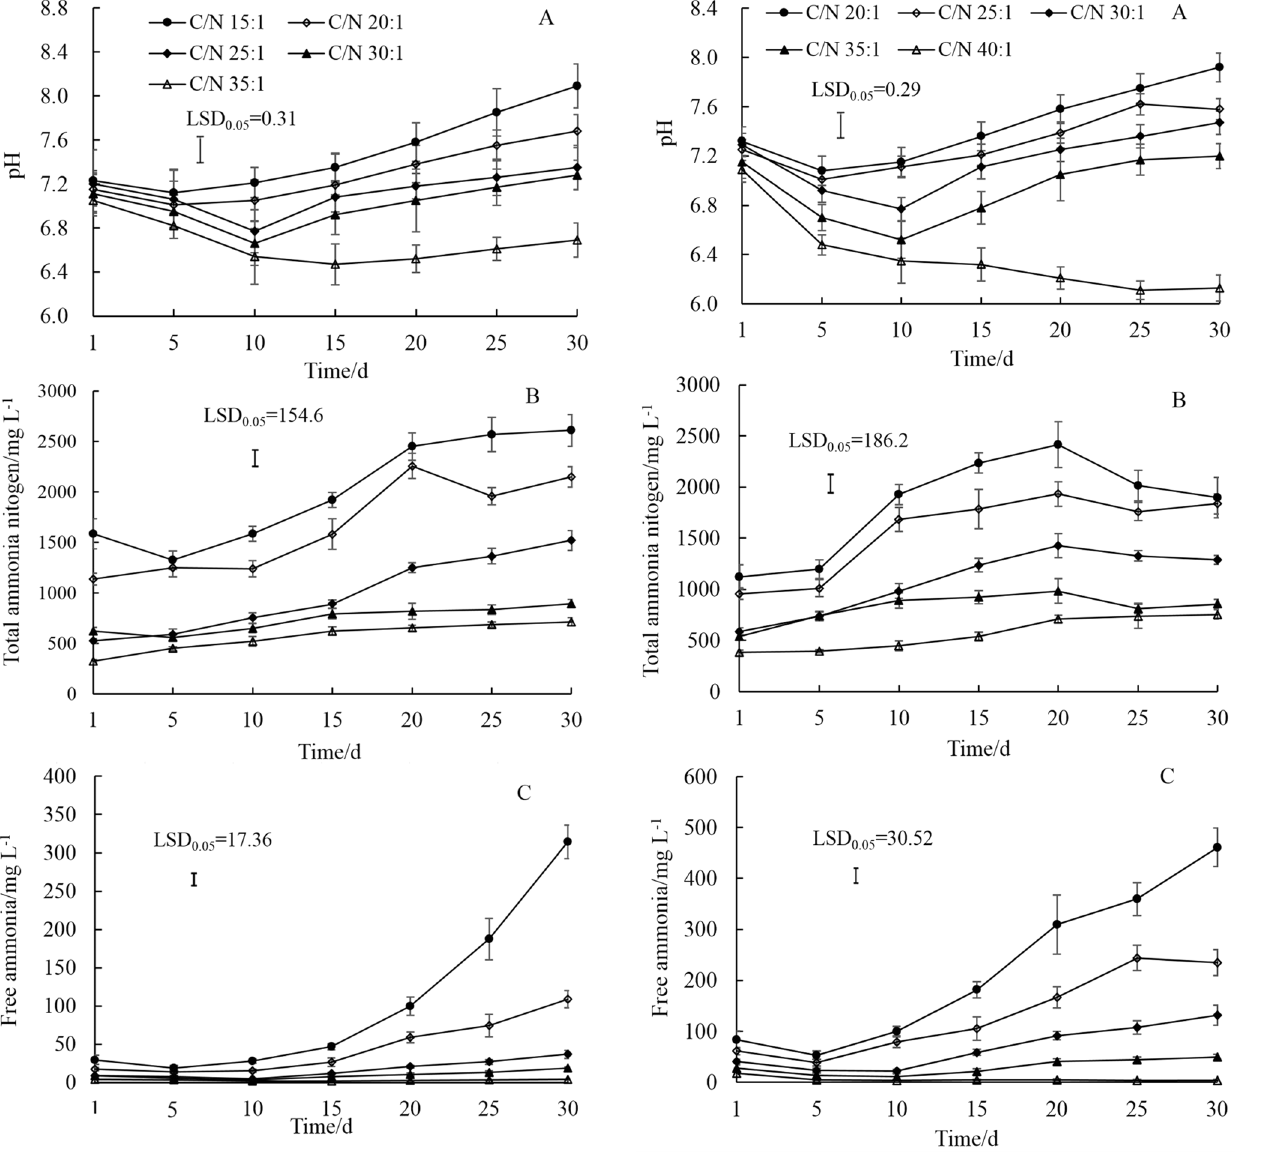
Figure 3. Changes of pH, total ammonium nitrogen, and free ammonia with different C/N ratios in the mixture of dairy manure (DM), chicken manure (CM), and rice straw (RS) IN anaerobic co-digestion at 55 6 C. Values are presented as the mean 6 standard error of three replicates (n=3). Values are presented as the mean 6 standard error of three replicates (n=3). Vertical bars represent LSD at the 5% level.